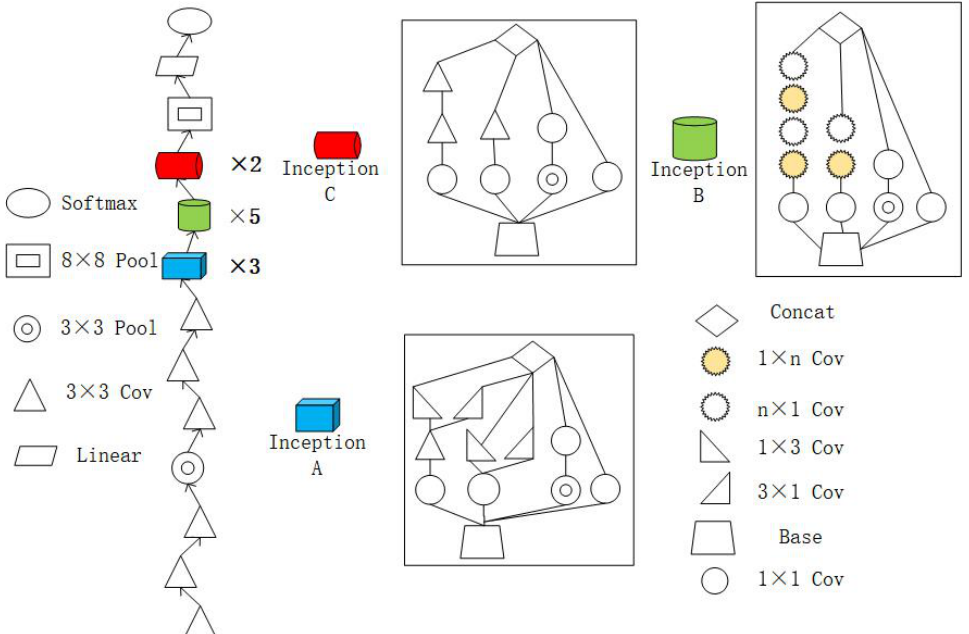
Figure 7. The architecture of GoogLeNet Inception V2 network [48]. Its basic convolutional block is named Inception. There are three kinds of Inception blocks in the network, Inception A, Inception B, and Inception C,